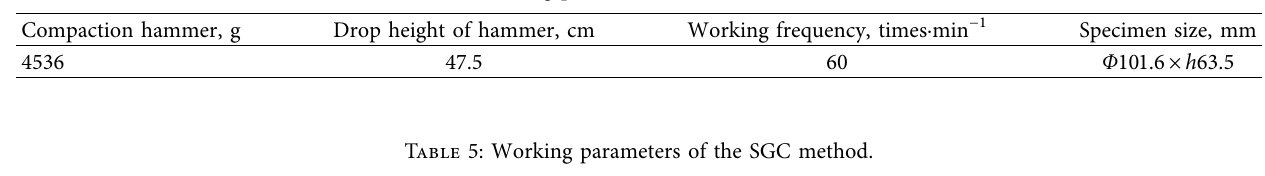
Table 4: Working parameters of the Marshall method.